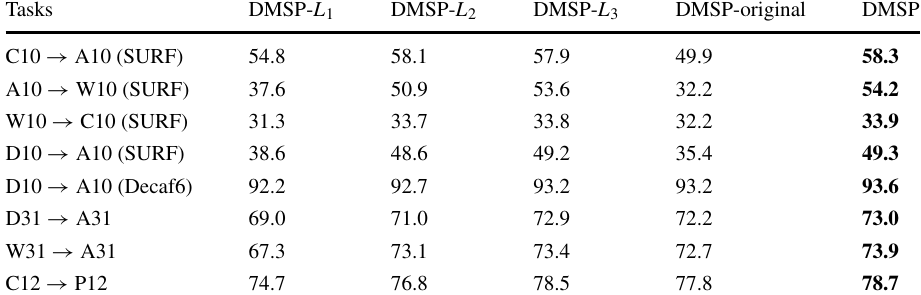
Table 5 Accuracy (%) on cross-domain classification tasks